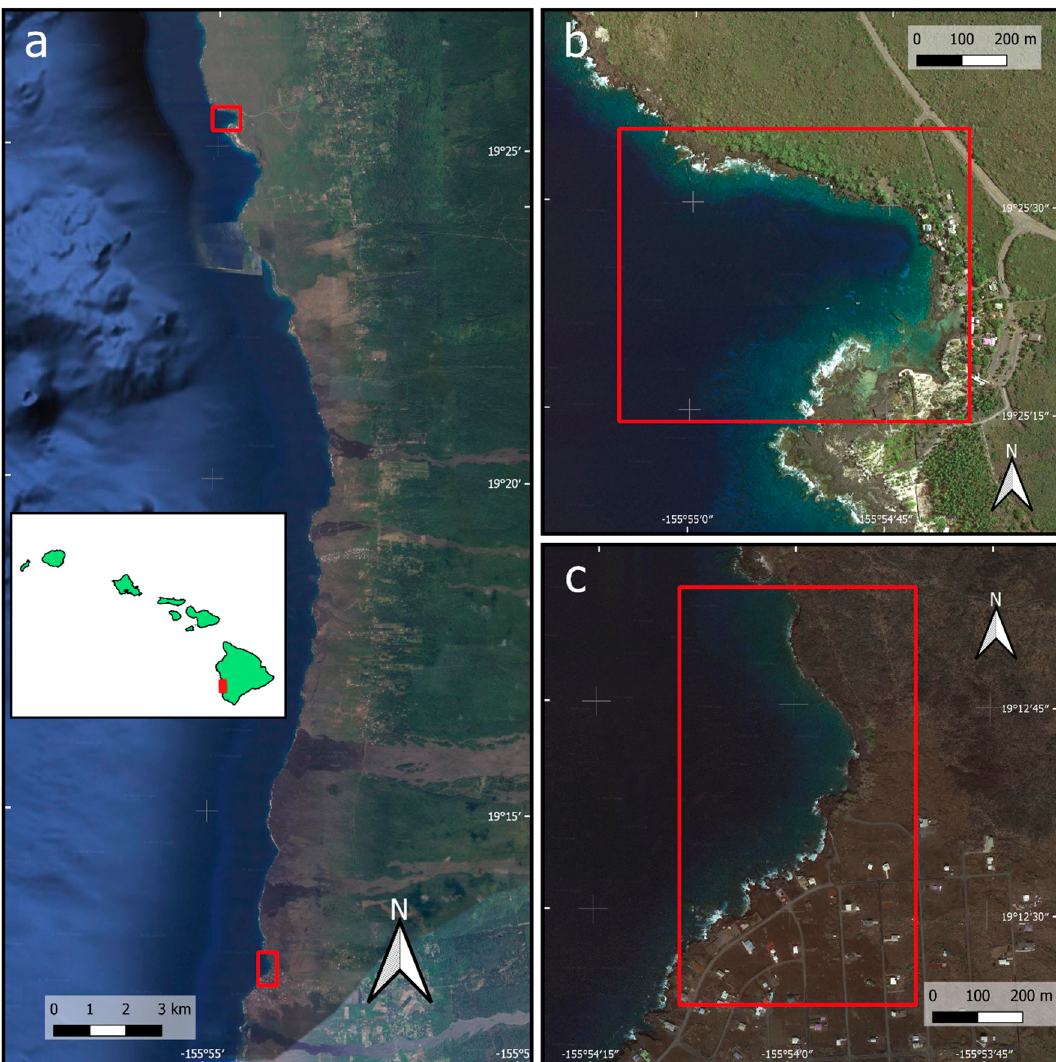
Figure 1. ( a ) Location of the two study bays on the west coast of Hawai’i Island. The two right panels provide a more detailed view of ( b ) Honaunau Bay and ( c ) P ā p ā Bay. Background satellite imagery © Google 2018.